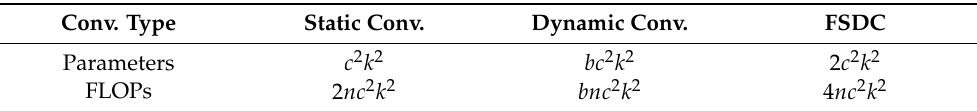
Table 1. Comparison of static convolution, dynamic convolution, and FSDC in terms of parameters and